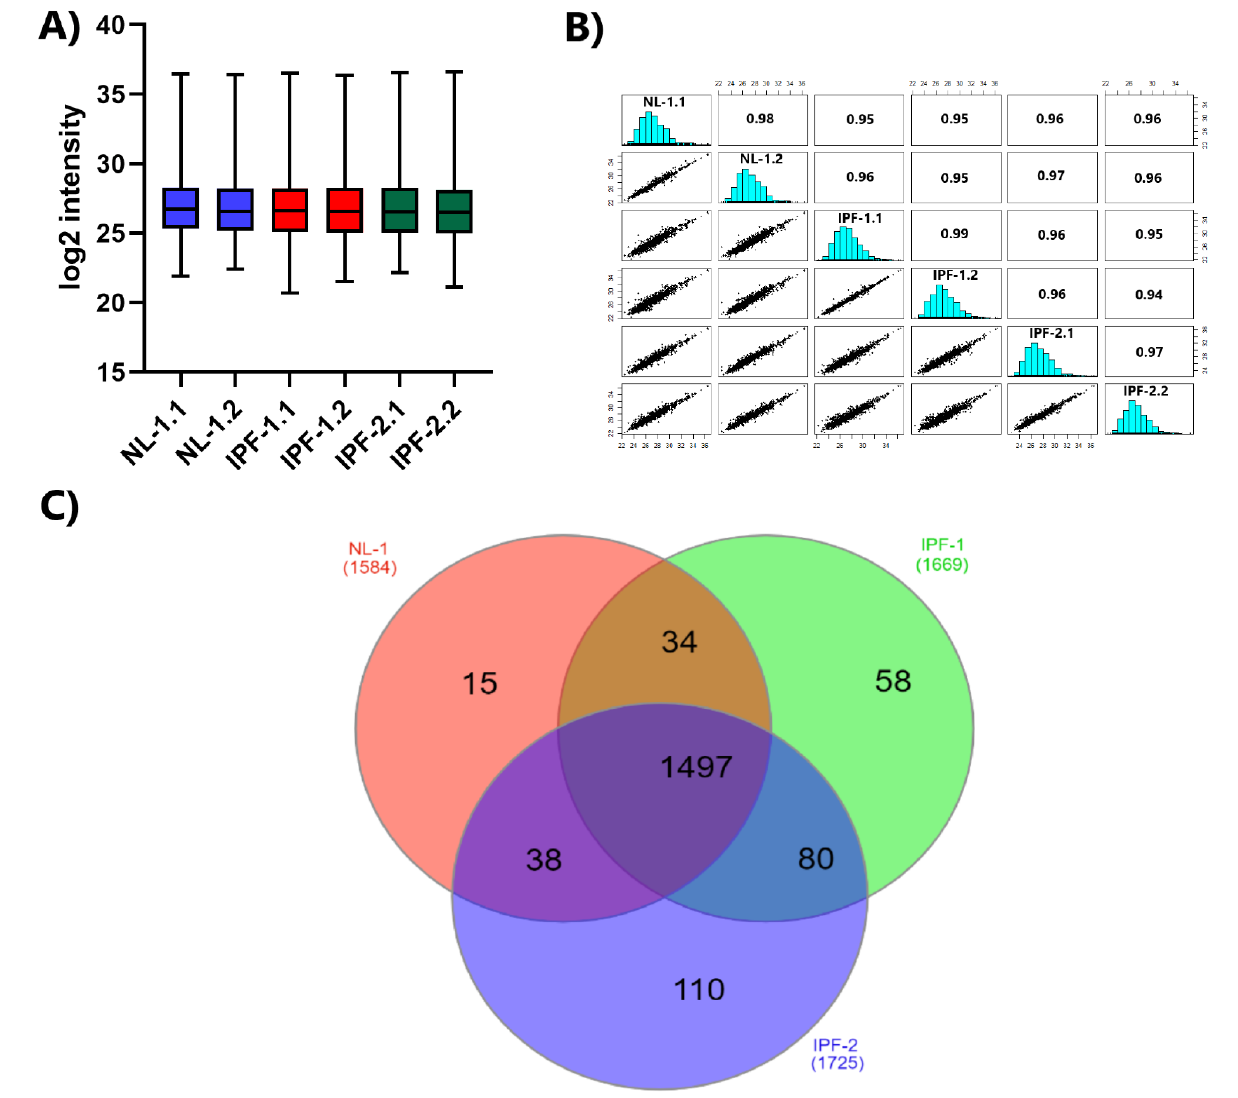
Figure 2. LC-MS/MS reproducibility and distribution of proteins identified. ( A ) Box plot of biological replicates of each cell line. ( B ) Correlation plot of biological replicates of all cell lines. ( C ) Venn diagram showing the distribution of proteins in the different cell lines. IPF, idiopathic pulmonary fibrosis; NL, normal lung.